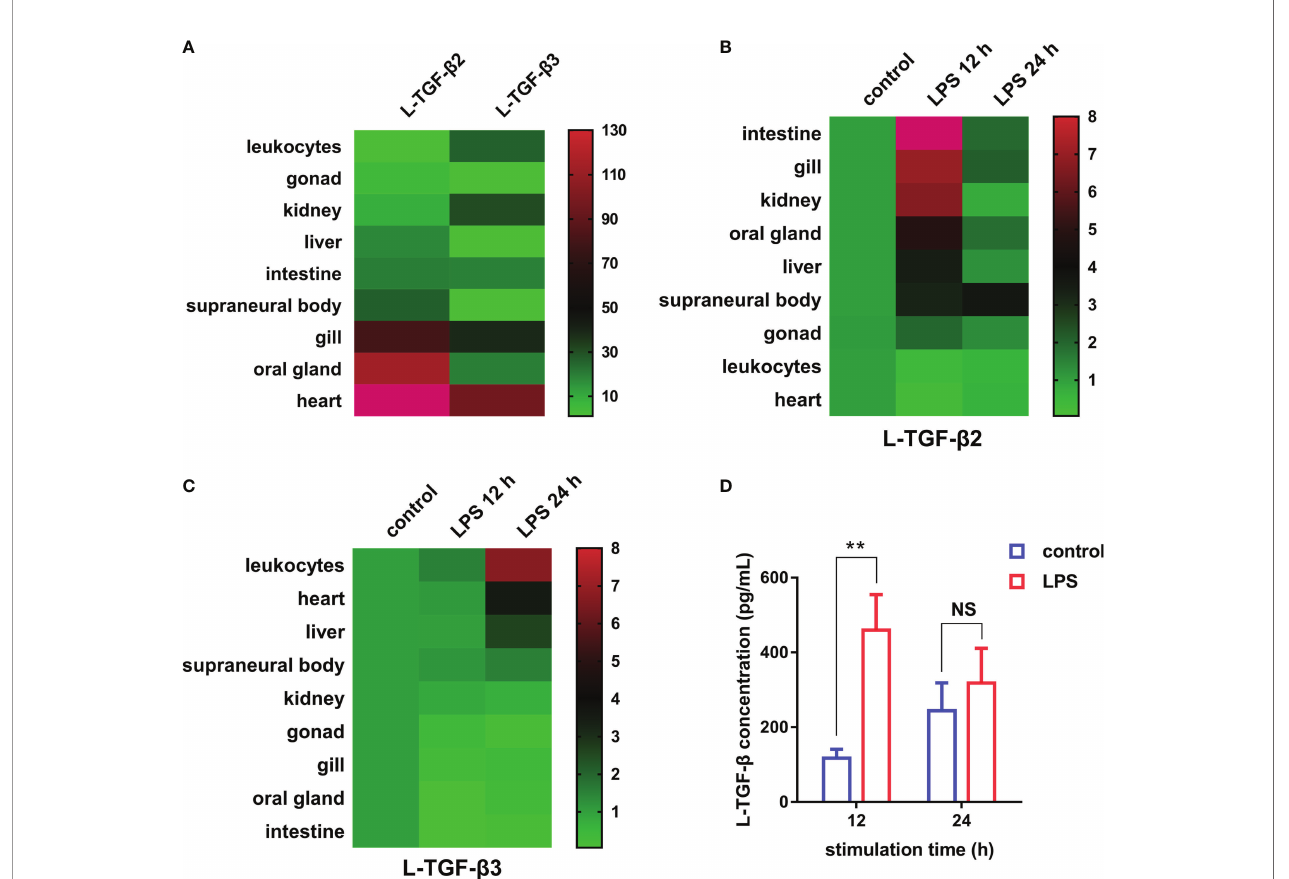
FIGURE 4 | Expression pro fi les of TGF- b s in the Japanese lamprey. (A) Heatmap of the tissue distribution of L-TGF- b 2 and L-TGF- b 3 determined by real-time PCR. For L-TGF- b 2, its relative expression level in leukocytes was set to 1, while for L-TGF- b 3, its relative expression level in the liver was set to 1. Colorized matrixes highlight the high expressing tissues in red, the low expressing tissues in green and the median expression in black as shown in the color scale. (B, C) Heatmaps of the changes in L-TGF- b s expression levels before and after LPS immunization. The expression levels of L-TGF- b 2 (B) and L-TGF- b 3 (C) after 12 and 24 hours of LPS stimulation relative to those in unimmunized lampreys were analyzed using real-time PCR. The green and red in colorized matrixes indicate low to high expression levels, respectively. The experiments were repeated 3 times independently. (D) Changes in the level of L-TGF- b proteins secreted by SMB cells. The total amount of L-TGF- b s including the latent and activated forms in the supernatant of primary cultured SMB cells after 12 and 24 hours of in vitro LPS stimulation were determined using a customized sandwich ELISA kit. The standard curve is shown in Supplementary Figure 1 . Error bars represent mean ± SEM from three independent experiments. Statistical signi fi cance was calculated using a two-tailed unpaired t -test. **: p < 0.01, NS, Not signi fi